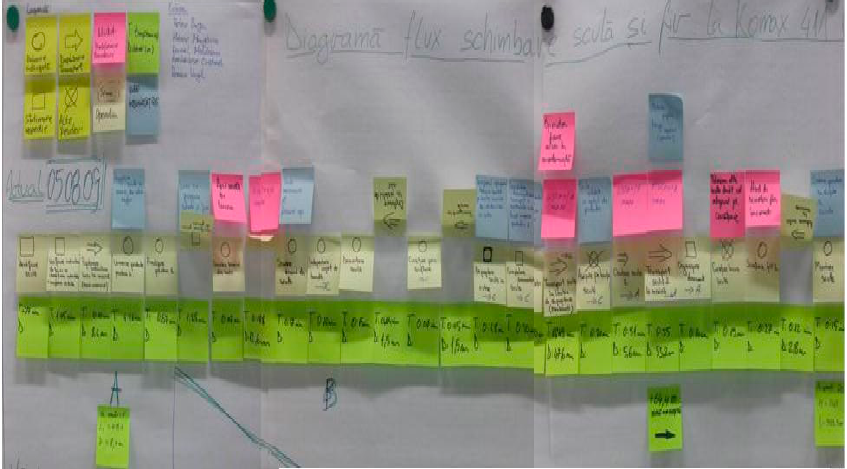
Figure 5. Value Stream Mapping (VSM).